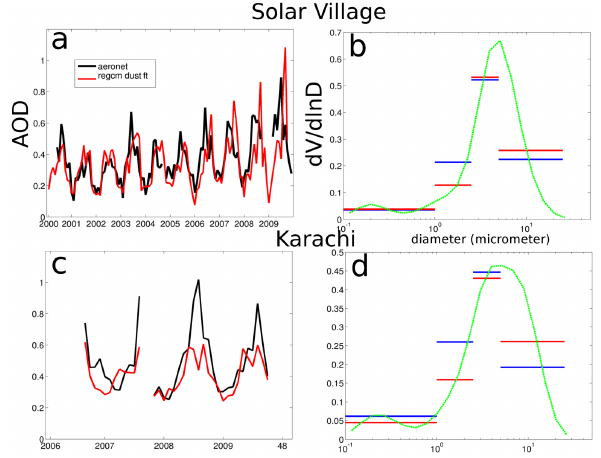
Figure 9. (a) Comparison between simulated and AERONET monthly AODs (see text) for Solar Village station. (b) Comparison of simulated and measured aerosol normalized volume size distri- bution averaged for JJAS 2009 over Solar Village. For comparison, the AERONET normalized volume distribution (green dotted line) is re-binned using a weighted average between model bins cutoff diameters (red lines). Blue lines show the corresponding simulated four-bin distribution for the same cutoff diameters. (c) Same as (a) for Karachi station. (d) Same as (b) for Karachi station.